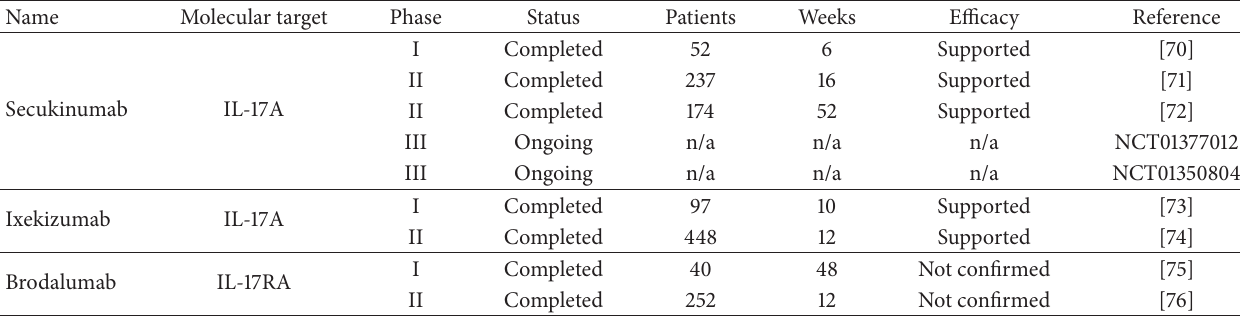
Table 2: Summary of the most important therapeutical trials targeting IL-17 in